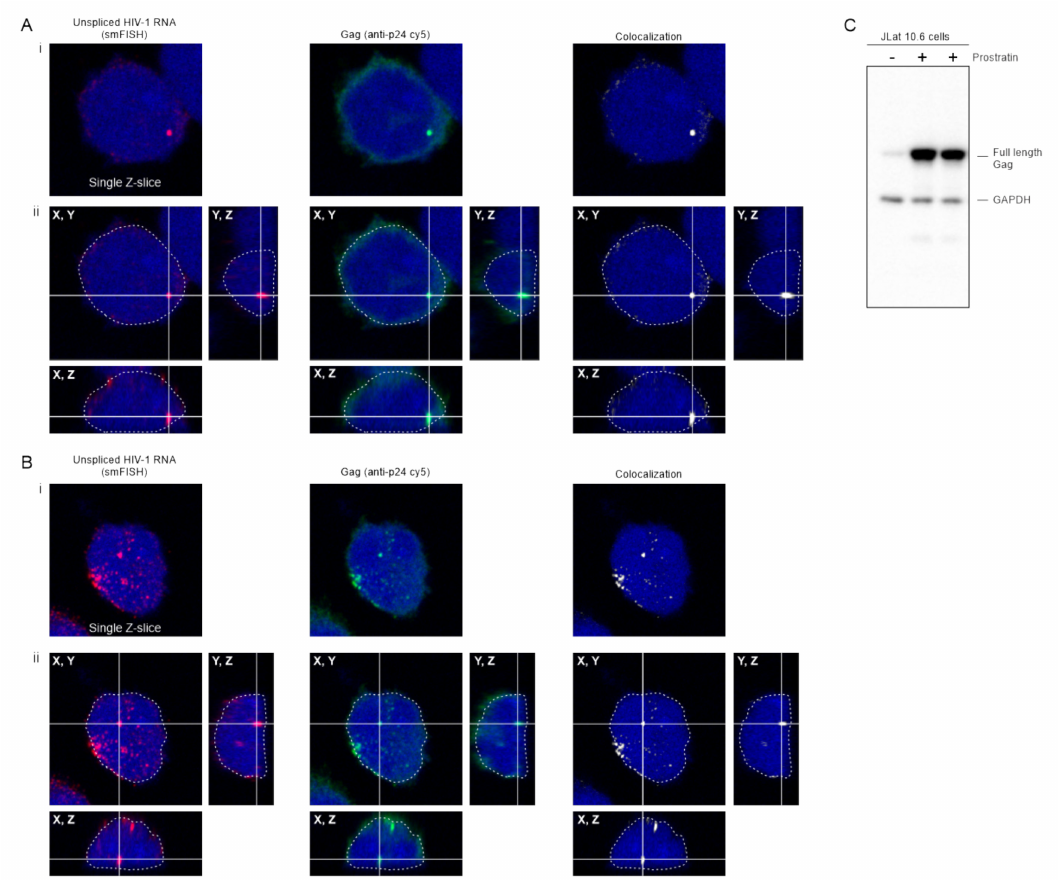
Figure 8. HIV-1 Gag and co-localizes with USvRNA in the nucleus of JLat 10.6 cells. ( A , B ) Confocal images showing ( i ) single z-slices and ( ii ) cross-sections of three-dimensional reconstructions of two examples of JLat 10.6 cells activated by prostratin. USvRNA labeled via smFISH (red) is co-localized with full-length HIV-1 Gag (anti-p24 cy5 labeled; green) in the nucleus outlined in white dashed line (DAPI, blue). A co-localization channel (white) was generated to show that the Gag and USvRNA signals are present in the same pixels of the image. In each cell, a vRNP consisting of USvRNA and Gag was present within a crosshair to show its location within the nucleus in three planes. ( C ) Immunoblot of JLat 10.6 whole cell lysates in the absence (-) or presence ( + ) of prostratin. The full-length Gag polyprotein was present in cells reactivated from latency. GAPDH served as a loading